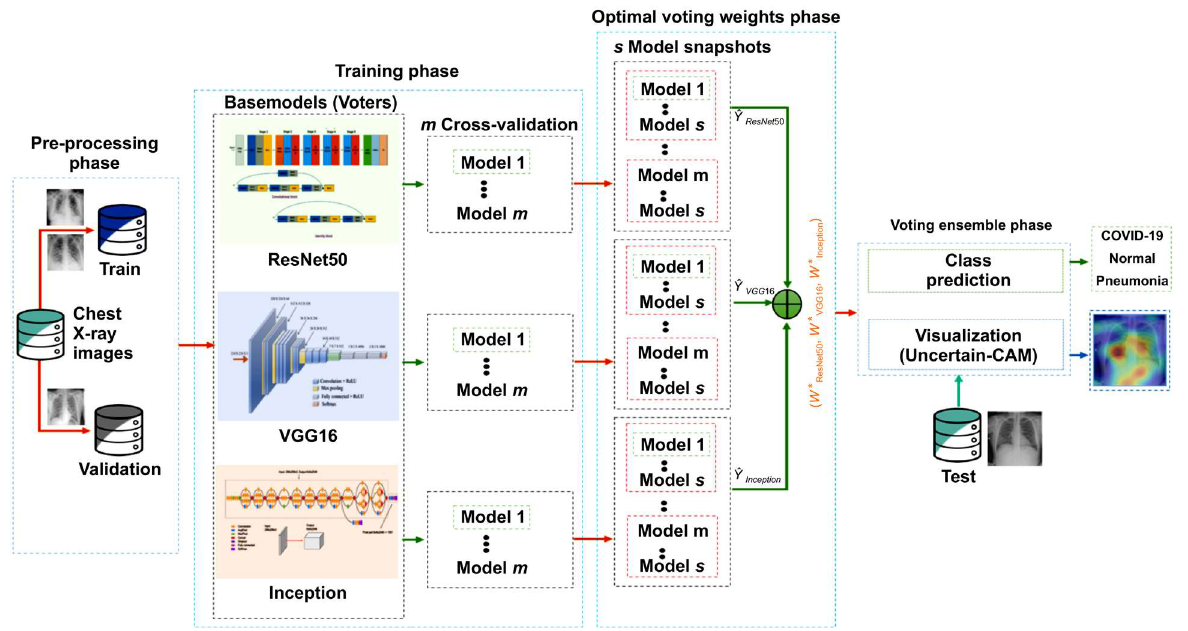
Figure 1. Framework of the proposed method. In the preprocessing stage, data were prepared for training phase wherein we generate m models using cross-validation for each CNN network, and for each model, we generate s snapshots models using cyclic cosine annealing. Snapshots models were used to obtain optimal voting weight.